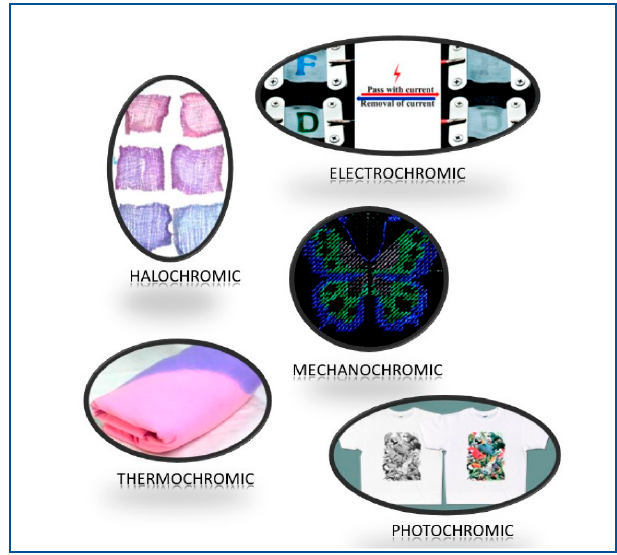
Figure 7. Examples of smart color-changing fabric textiles under different chromic effects [35,36].